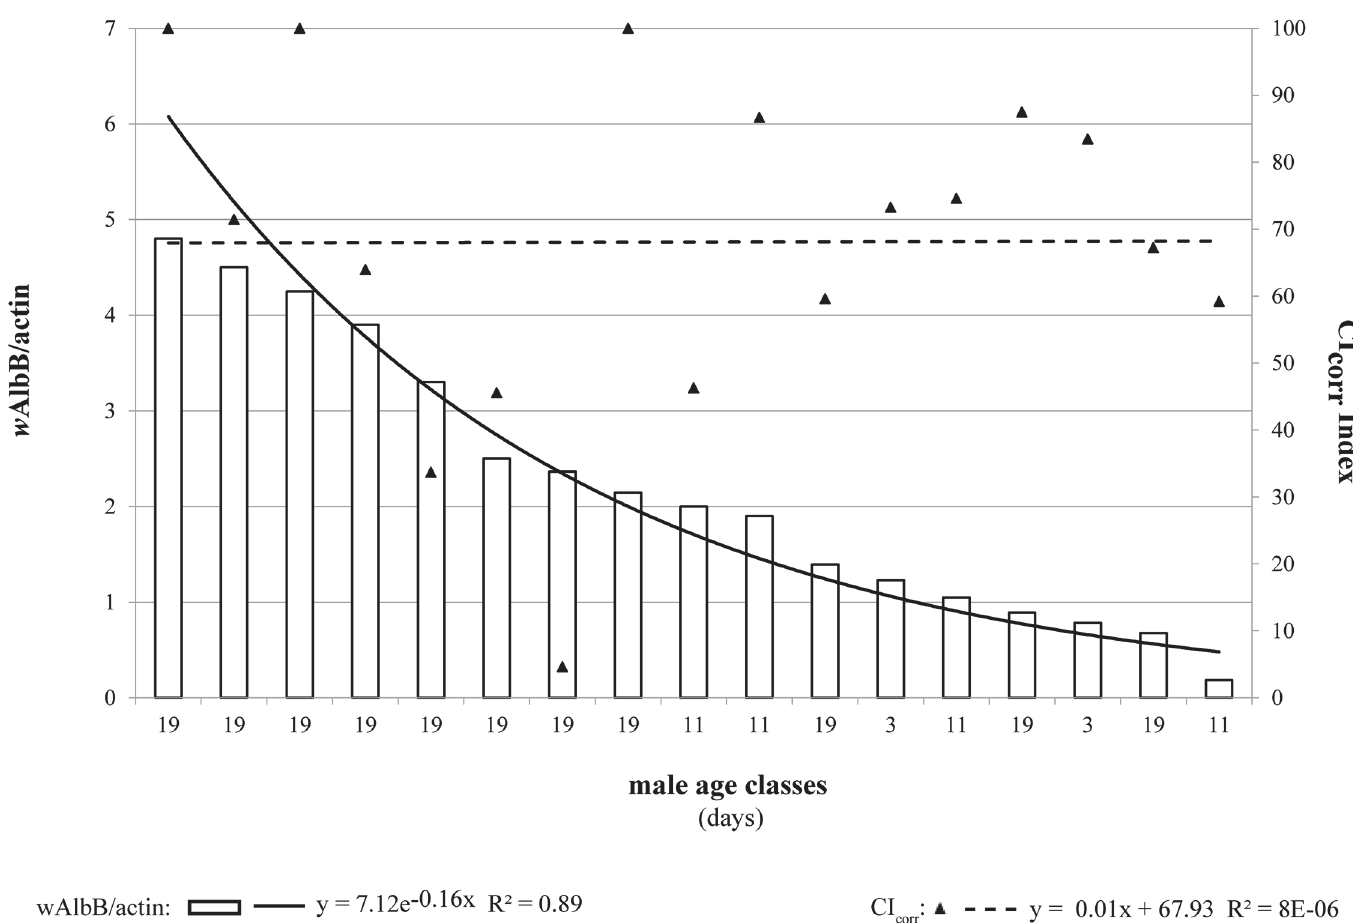
Fig 5. Correlation between w AlbB density and expressed CI level (CI corr index) in Ae . albopictus males characterized by very low w AlbA titer when crossed with AR w P females. Data trend is displayed via a polynomial trend-line together with the associated function.